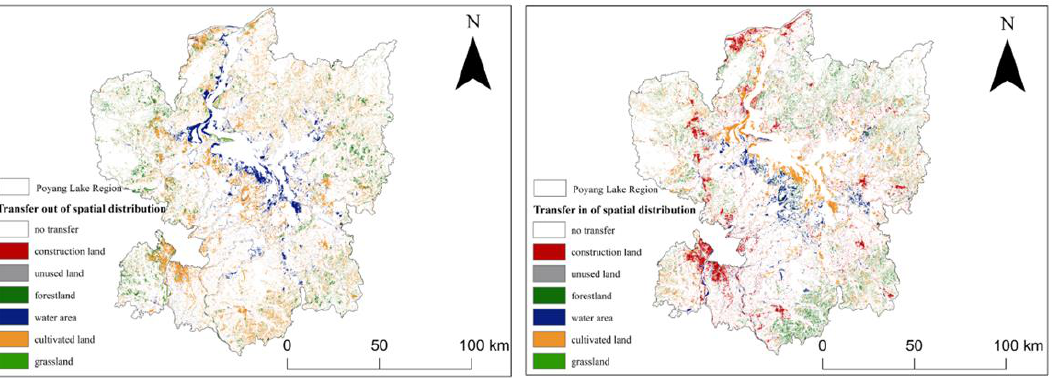
Figure 5. Spatial distribution of transfer-out ( left ) and transfer in ( right ) land during 1990 – 2020.